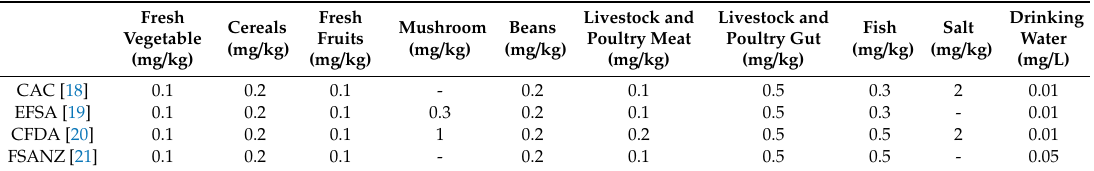
Table 1. Permitted maximum amount of